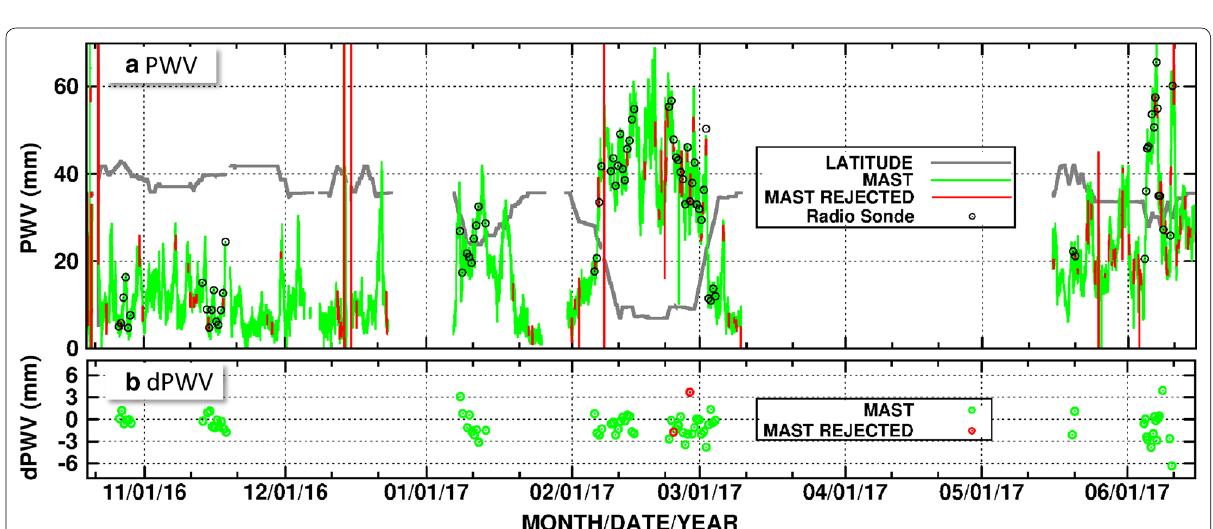
Fig. 6 a Time sequence of PWV for the entire observation period (green line: retrieved from the MAST measurements, led line: same with green line but rejected through the quality control procedure, black circles: radiosonde). Thick gray line represents latitude of the vessel. b Anomaly plots of GNSS PWV from the MAST measurements against radiosonde observations. Two red circles are rejected through the quality